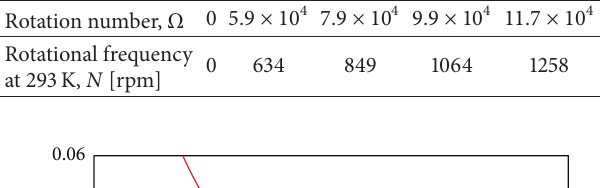
Table 1: Rotational speed of stirring disc.